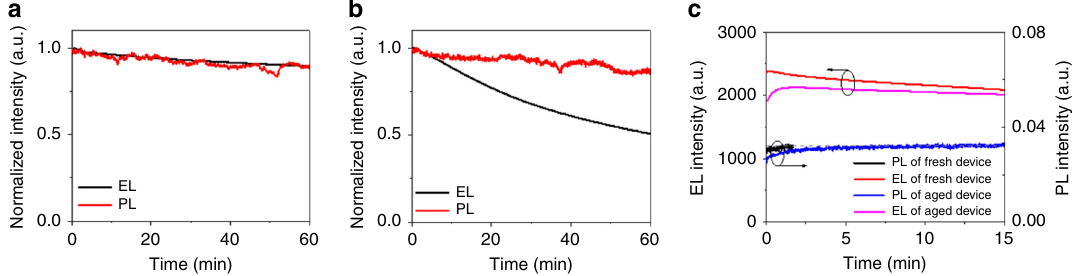
Fig. 5 PL and EL intensities of a working 1.0 DDS fi lm-based LED. Simultaneously measured PL and EL intensities at ( a ) a low driving voltage of 2.1 V and ( b ) high driving voltage of 2.8 V, respectively. c Alternate EL and PL intensity measurements of a device before and after aging (Black line: fi rst measure the PL intensity on the fresh device; red line: turn off the laser and measure the EL intensities at a constant current density of 100 mA cm − 2 for 15 min; blue line: remove bias and measure the PL intensities again; magenta line: turn off the laser and measure the EL intensities again at a constant current density of 100 mA cm − 2 ). The EL intensity measurements at 100 mA cm − 2 are the